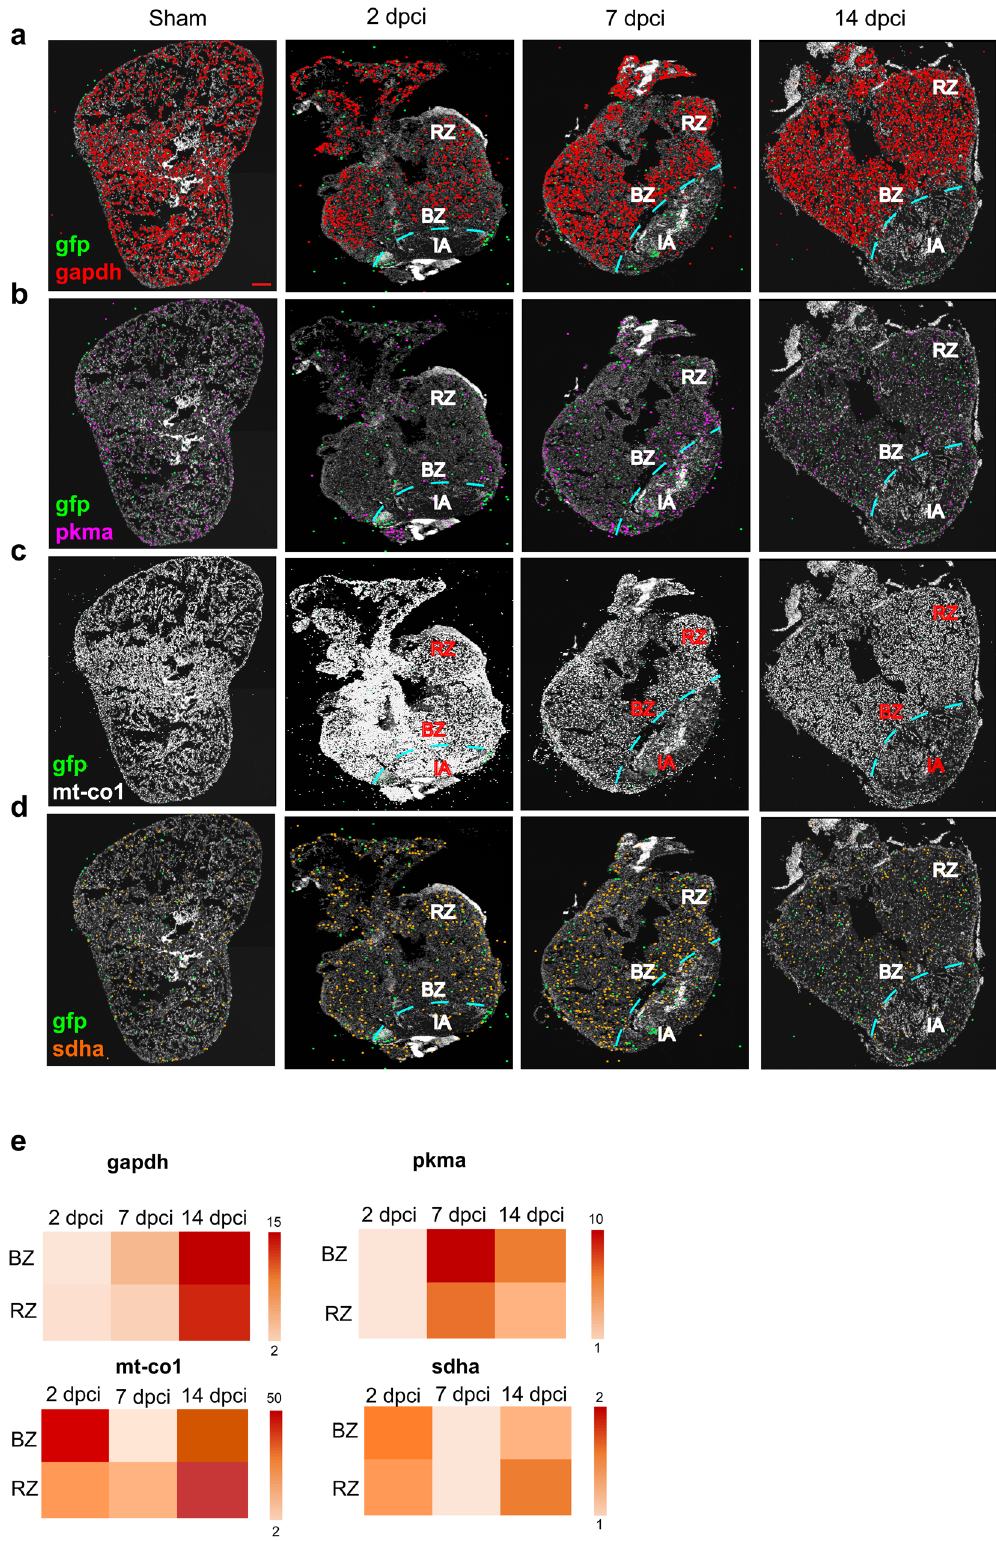
Fig. 2 Cardiomyocyte targeted in situ sequencing. A targeted multiplexed mRNA detection assay employing padlock probes, rolling circle ampli fi cation (RCA), and barcode sequencing was applied to detect the spatial distribution of a gapdh b pkma c mt-co1 and d sdha in sham and at 2, 7 and 14 dpci. All the experiments were performed on cmlc2 zebra fi sh transgenic strain, where a green fl uorescent protein ( gfp ) gene was inserted under the promoter of cardiomyocyte-speci fi c gene cardiac myosin light chain 2. For this reason, gfp was chosen as a cardiomyocyte marker. IA injured area, BZ border zone, RZ remote zone. Scale bar = 100 μ m. e Heatmaps showing the expression comparison of gapdh , pkma , mt-co1 and sdha between BZ and RZ at each time point. Heat legend represents the relative quanti fi cation of the spot number and it is represented as fold change. Two biological replicates were